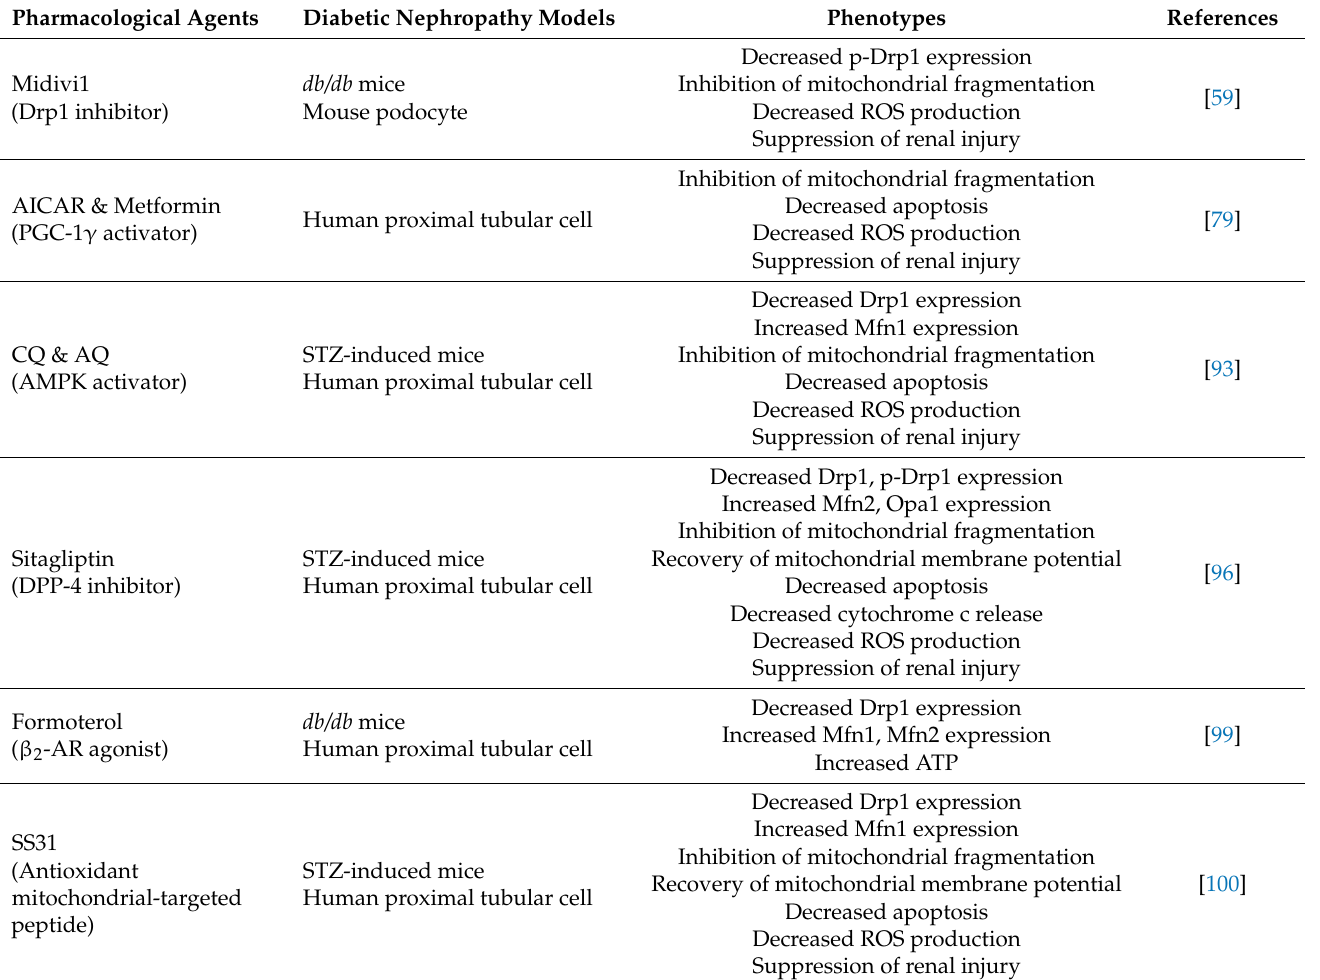
Table 2. Studies on the physiological function of pharmacological agents in diabetic nephropathy. Pharmacological